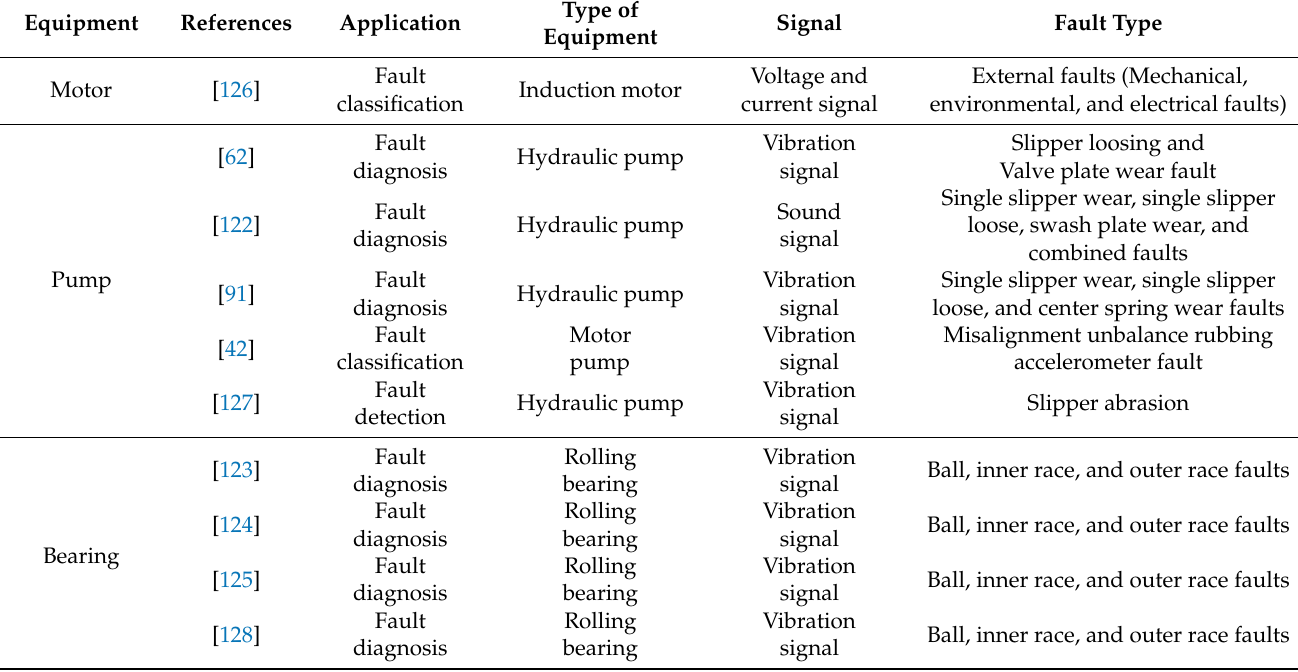
Table 16. Equipment condition monitoring using extreme learning